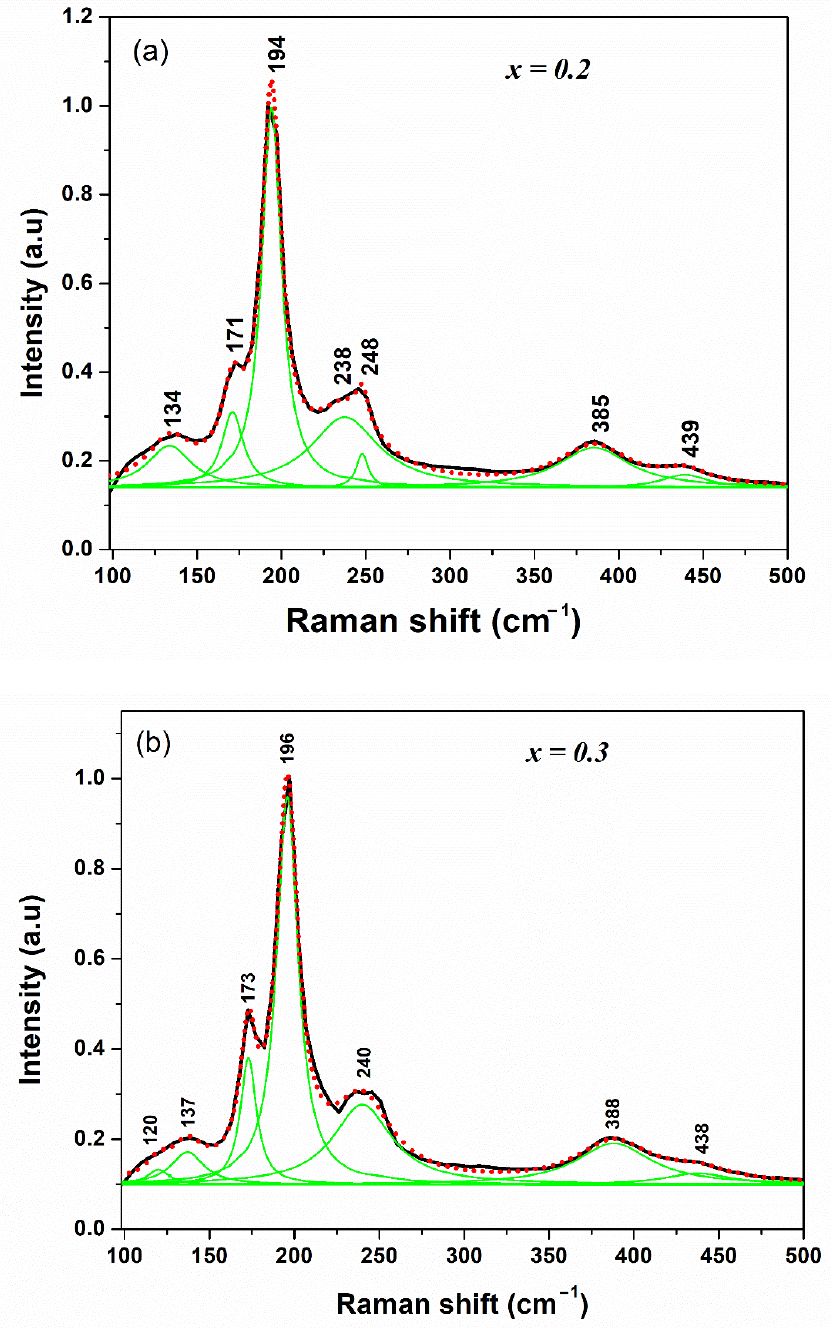
Figure 4. Raman spectrum of Cu 2 Zn(Sn 0.8 Si 0.2 )Se 4 ( x = 0.2) ( a ) and Cu 2 Zn(Sn 0.7 Si 0.3 )Se 4 ( x = 0.3) ( b ) samples with stannite structure. Contribution of the different peaks deduced from the fit with Lorentzian curves (green lines).